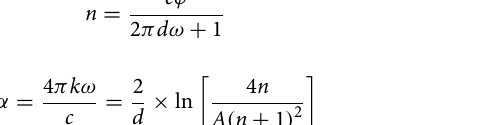
Femtosecond laser light was generated by a laser diode driven by a femtosecond laser (green line in Fig. 7). This light was divided by a beam splitter into two beams. One beam acted as a probe light (yellow line), and the other one (purple line) was focused on the GaAs photoconductive antenna 50,51 as a pump light to generate